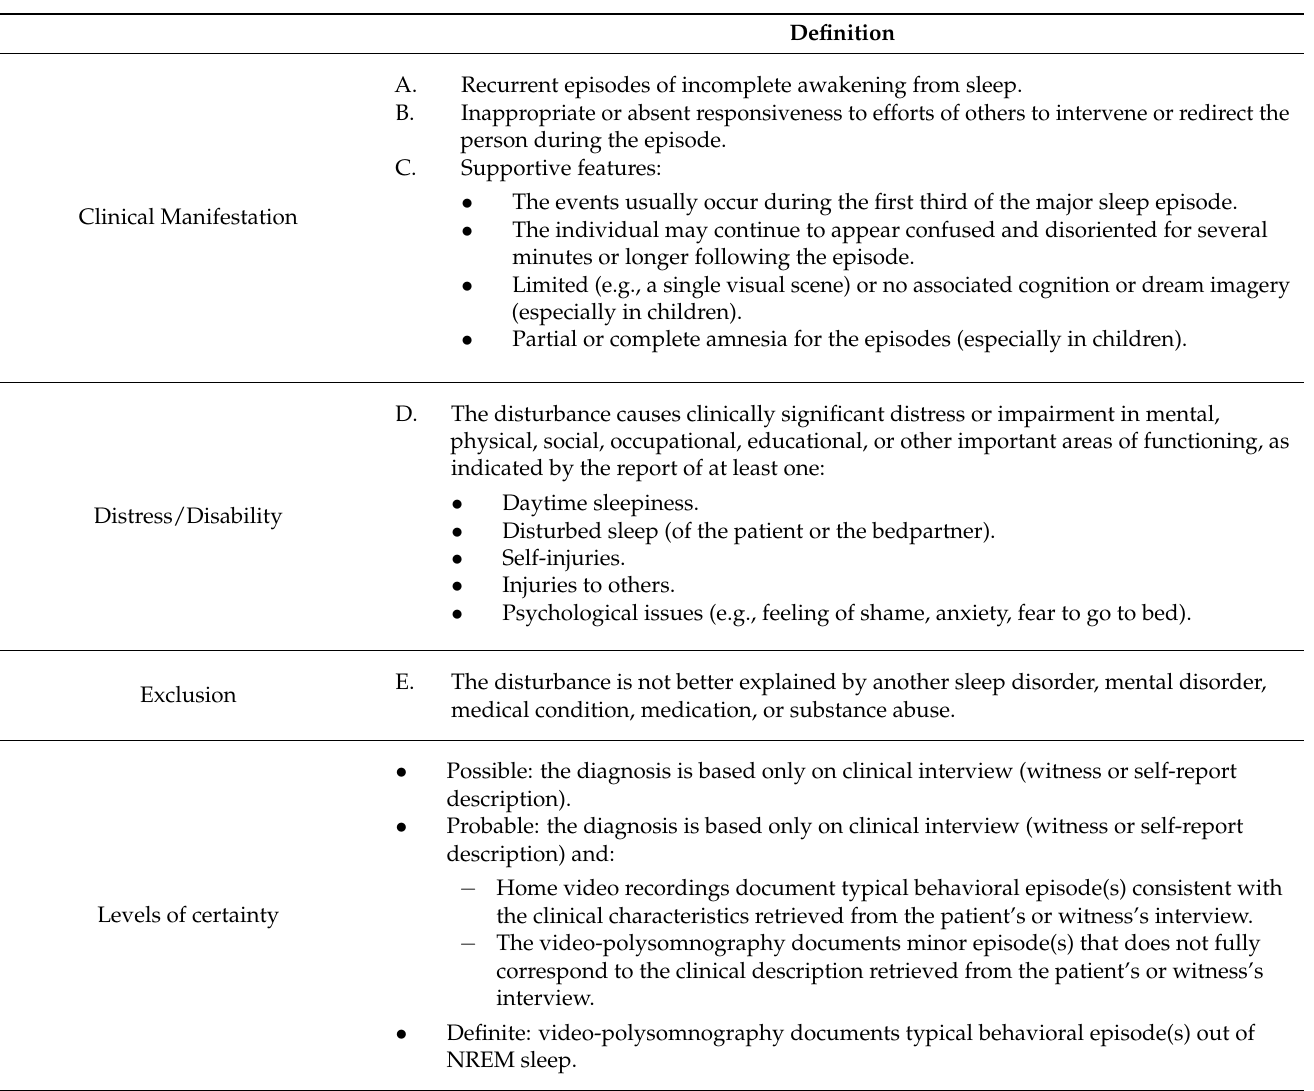
Table 2. Suggestions for new DoA diagnostic